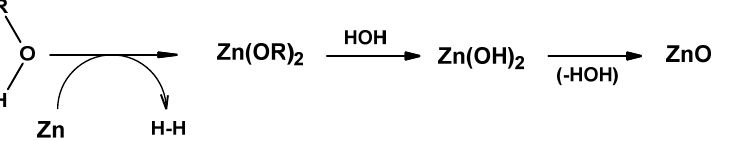
Table 3. Quantitative content of elements in individual samples based on the EDS test.